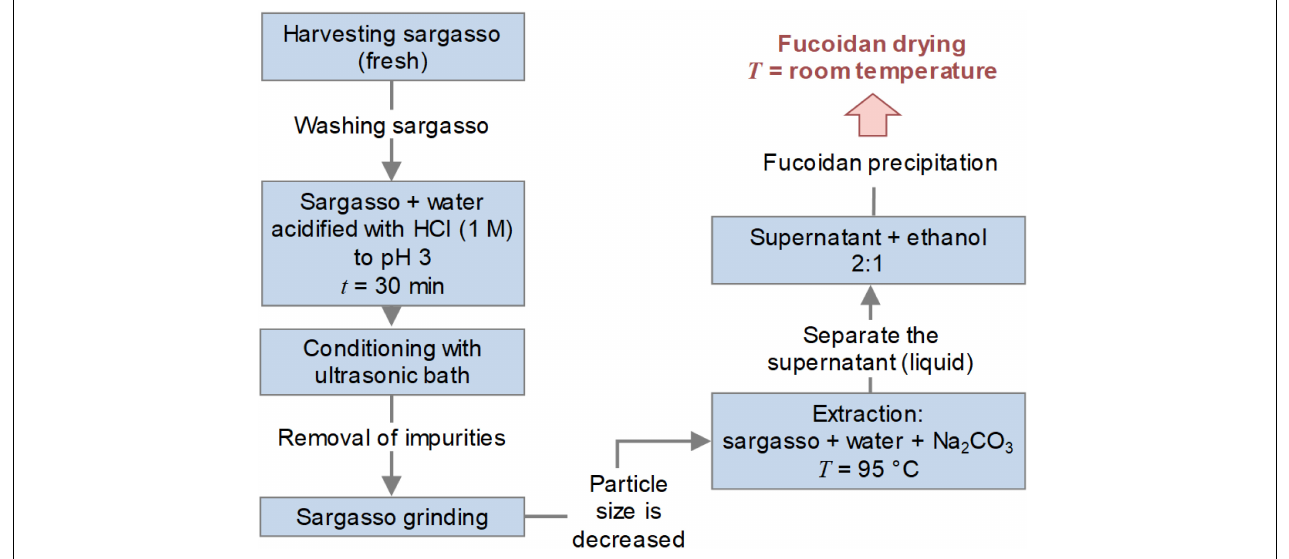
FIGURE 6 | The Creamos Más fucoidan extraction process.